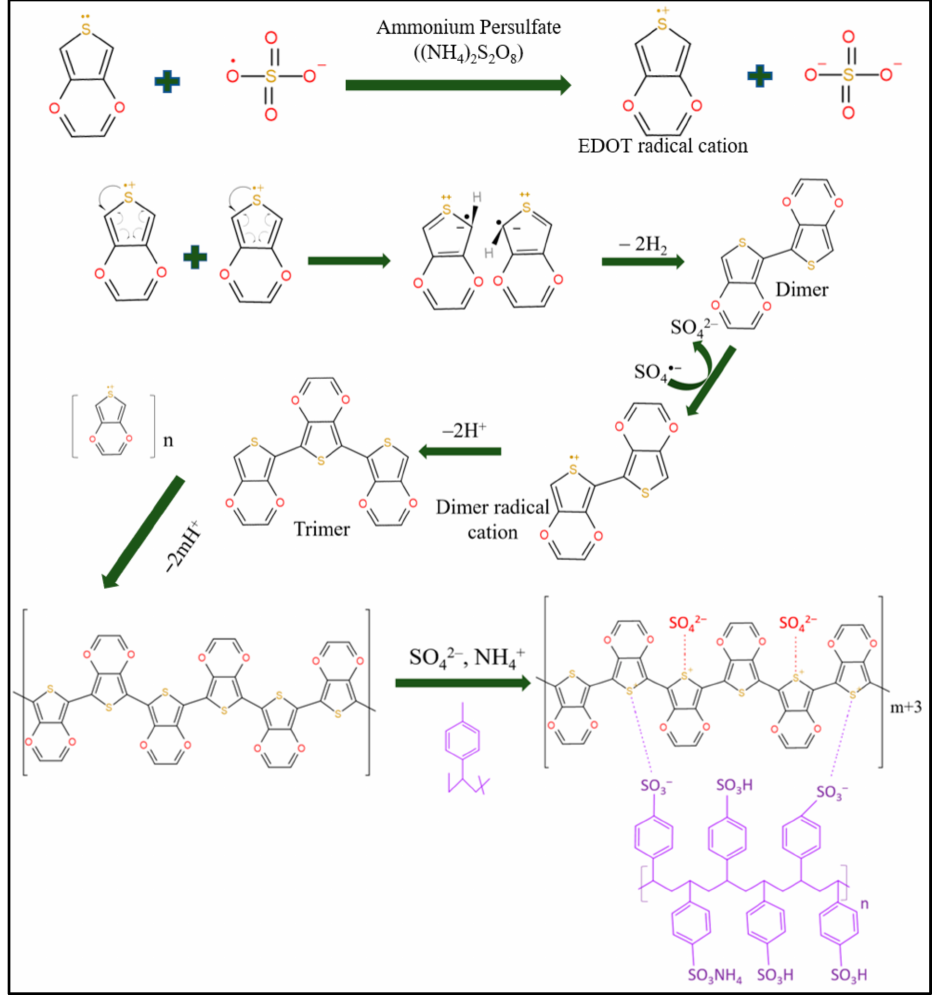
Figure 5. The oxidation step of the EDOT monomer; the propagation step, when the EDOT dimer becomes an EDOT trimer through the formation of a dimer radical cation; and a primary doping illustration of PEDOT: